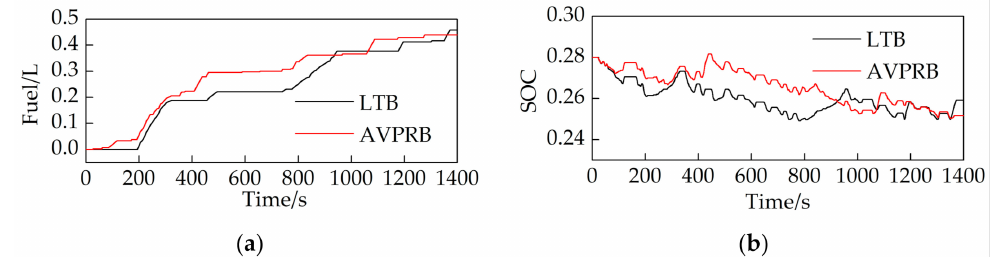
Figure 21. Fuel consumption and SOC of the two strategies under the FTP cycle: ( a ) fuel consumption; ( b ) SOC